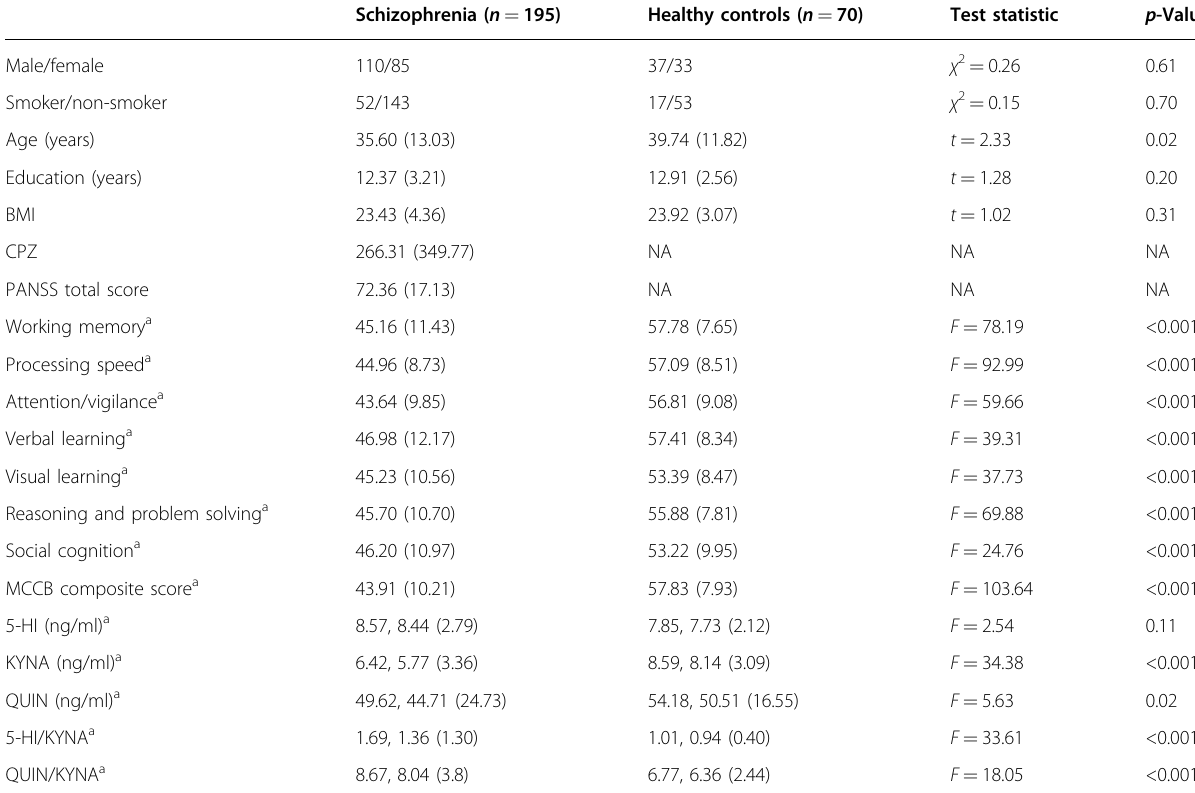
Table 1 Participant demographics, clinical characteristics, and metabolic